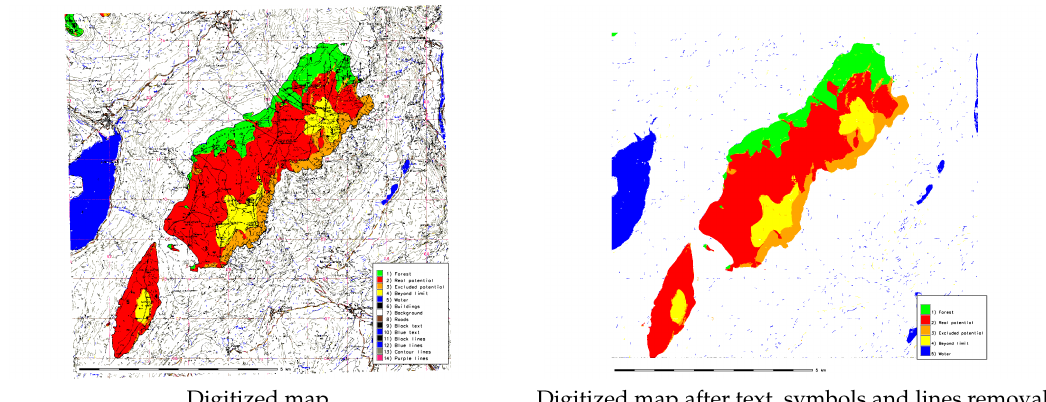
Figure 18. Digitized maps for the Map of the potential limit of the forest in Trentino (MPLFT) (particular), Best-Worst Weighted Vote (BWWV) voting